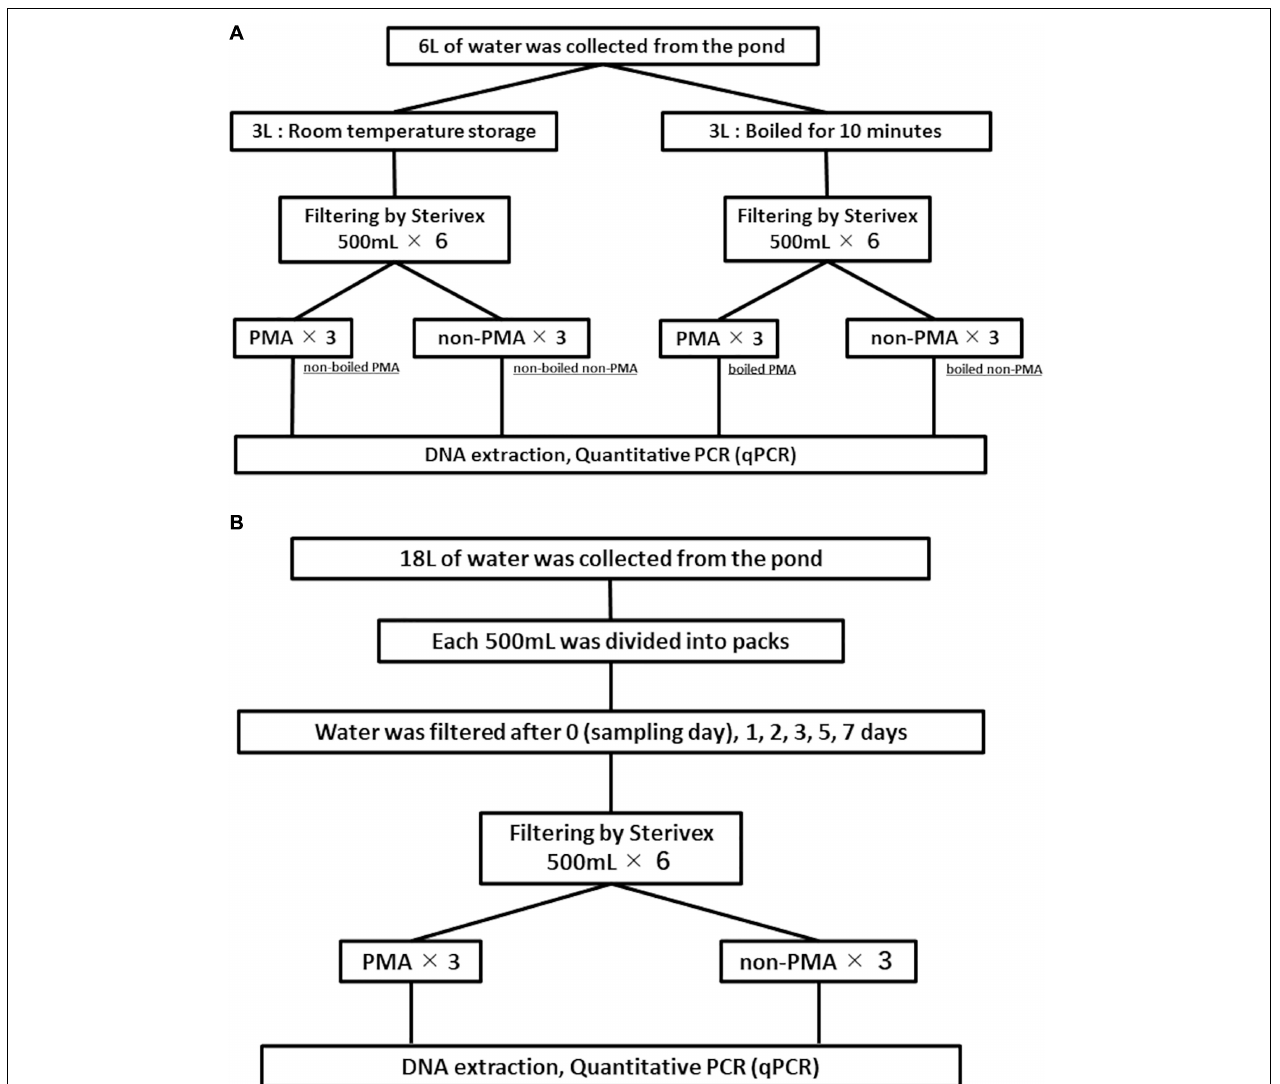
FIGURE 2 | Flowcharts for experiment 1 (A) and experiment 2 (B) . Filtration negative controls are not included in the